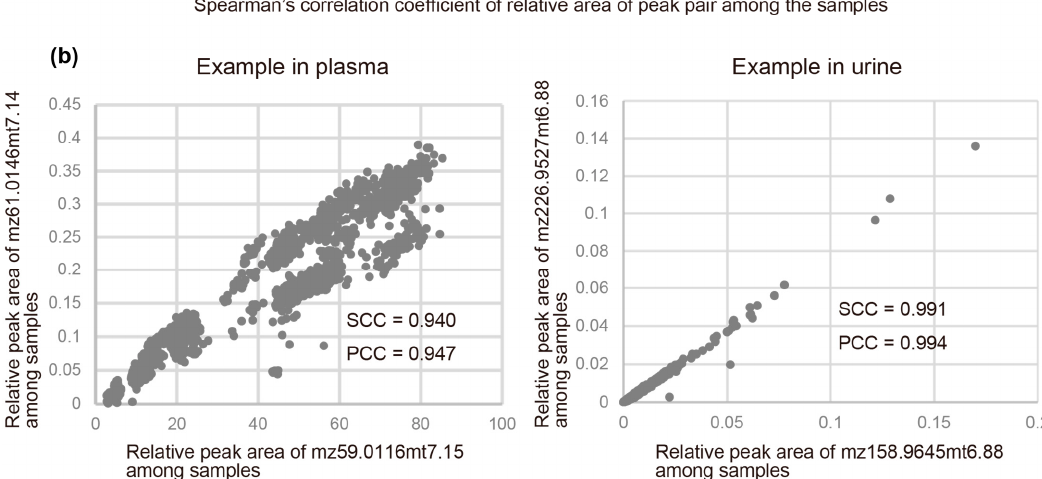
Figure 5. Peak pairs that had close migration times (MTs) whose peak areas showed high correlations over the plasma and urine samples. ( a ) Distribution of differences in migration times (dMT) for peak pairs with a specified range of correlations in their peak areas. ( b ) Representative example of uncharacterized peak pairs that have close migration times and high correlations among samples.